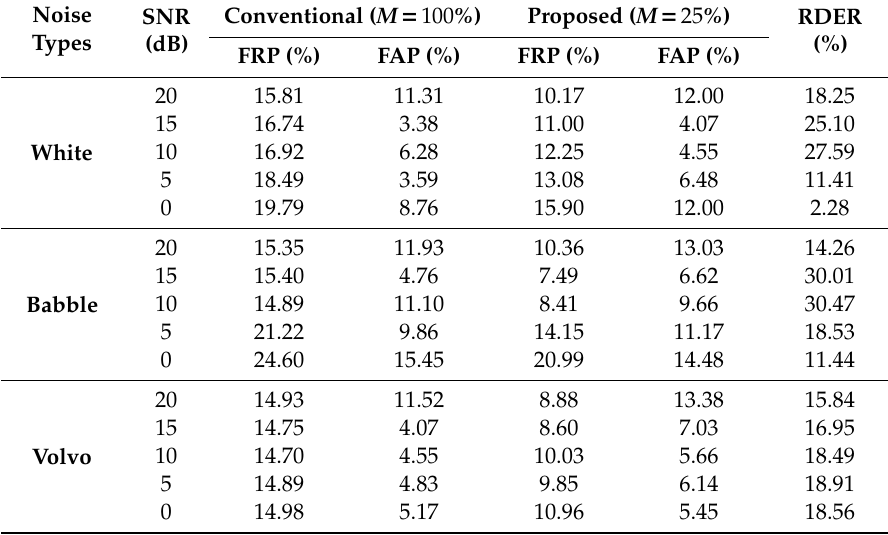
Figure 4. Detection error tradeoff curves for two noise types under the 5 dB SNR condition: ( a ) white noise and ( b ) babble noise. Table 2. FRP, false acceptance probability (FAP), and relative detection error reduction rate (RDER) (%) of a likelihood-ratio-test (LRT)-based VAD with and without proposed LR order statistics under various noise types and SNR conditions.